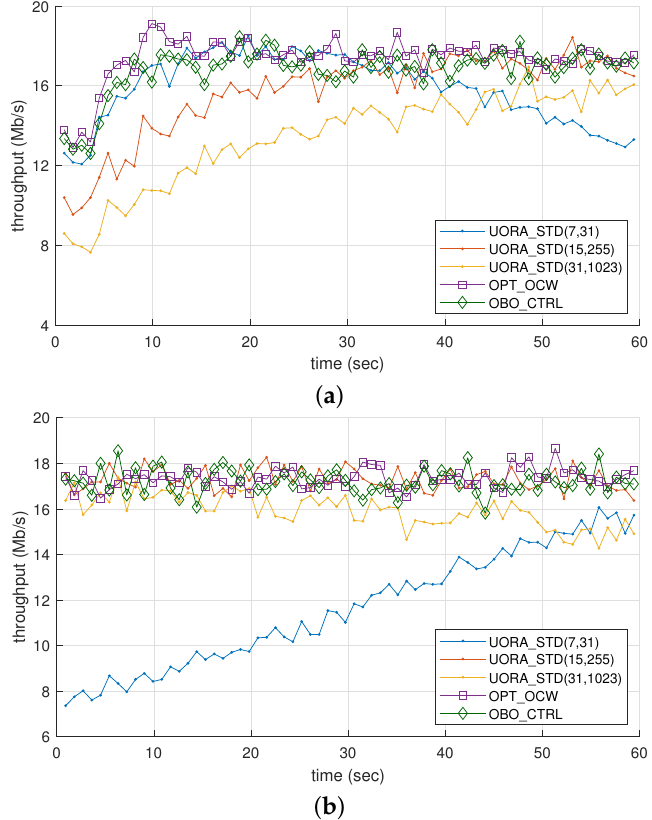
Figure 4. Throughput comparison of the UORA schemes under a dynamic network environment: ( a ) scenario 1 and ( b ) scenario